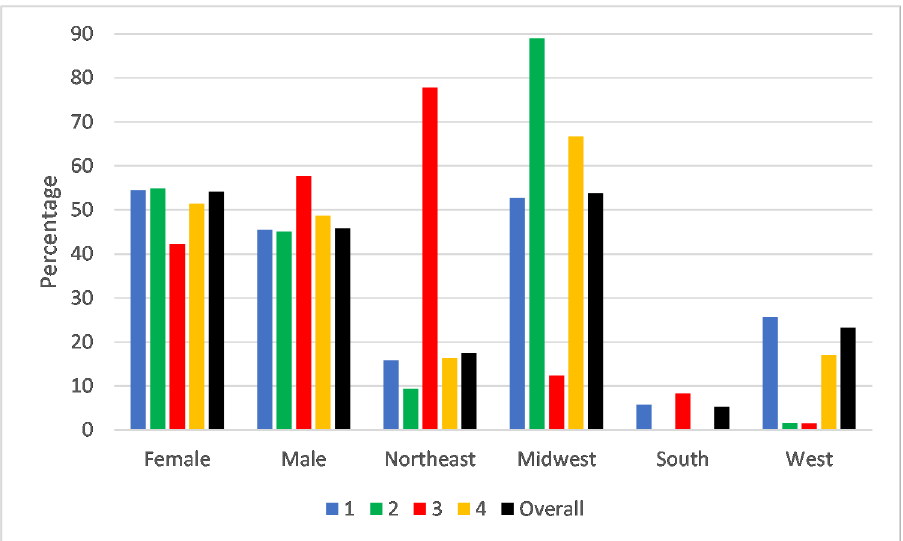
Figure 6. Percentage of individuals who fall into sex and geographic categories for overall sample of 10,000 and for each of the four clusters. Same information as in Table